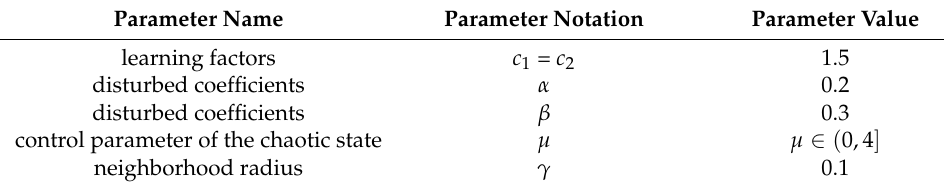
Table 2. Parameter setting.